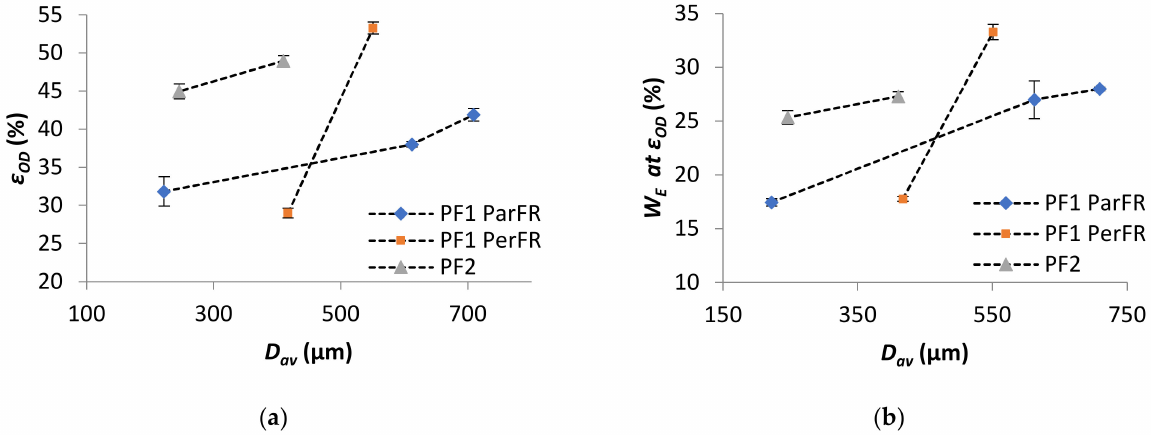
Figure 10. ( a ) ε OD as a function of D av and ( b ) W E as a function of D av